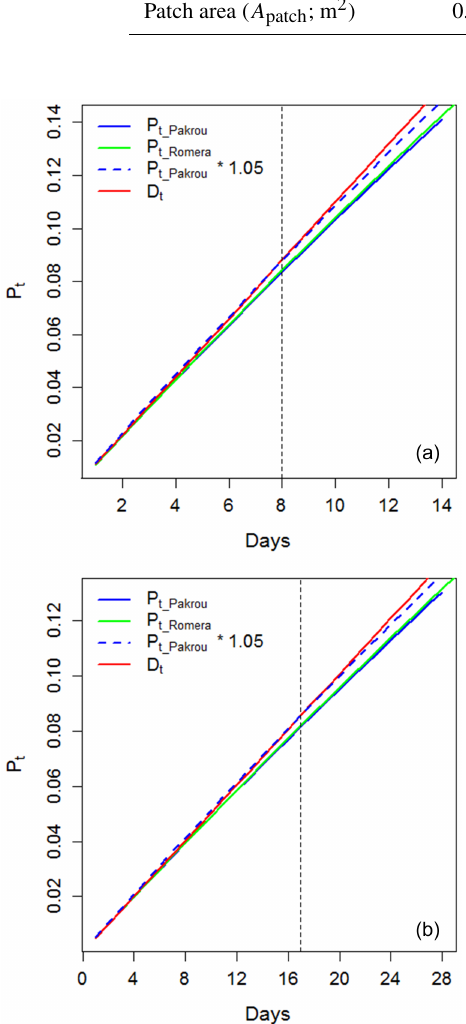
Figure 3. Proportion of the field covered by urine patches ( P t ) cal- culated for sheep (a) and cattle (b) as suggested by Pakrou and Dil- lon (2004; P t _Pakrou ) , Romera et al. (2012; P t _Romera ) and when there is no overlap between the patches ( D t )